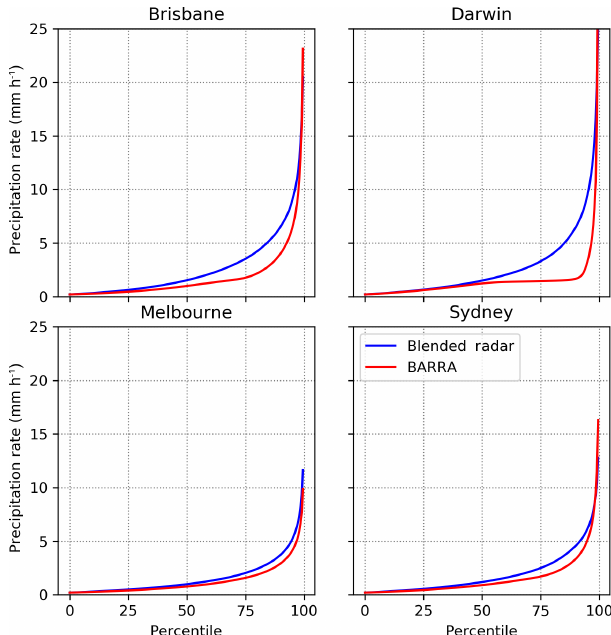
Figure 4. Hourly precipitation rates corresponding to quantiles for BARRA and blended radar data at four different